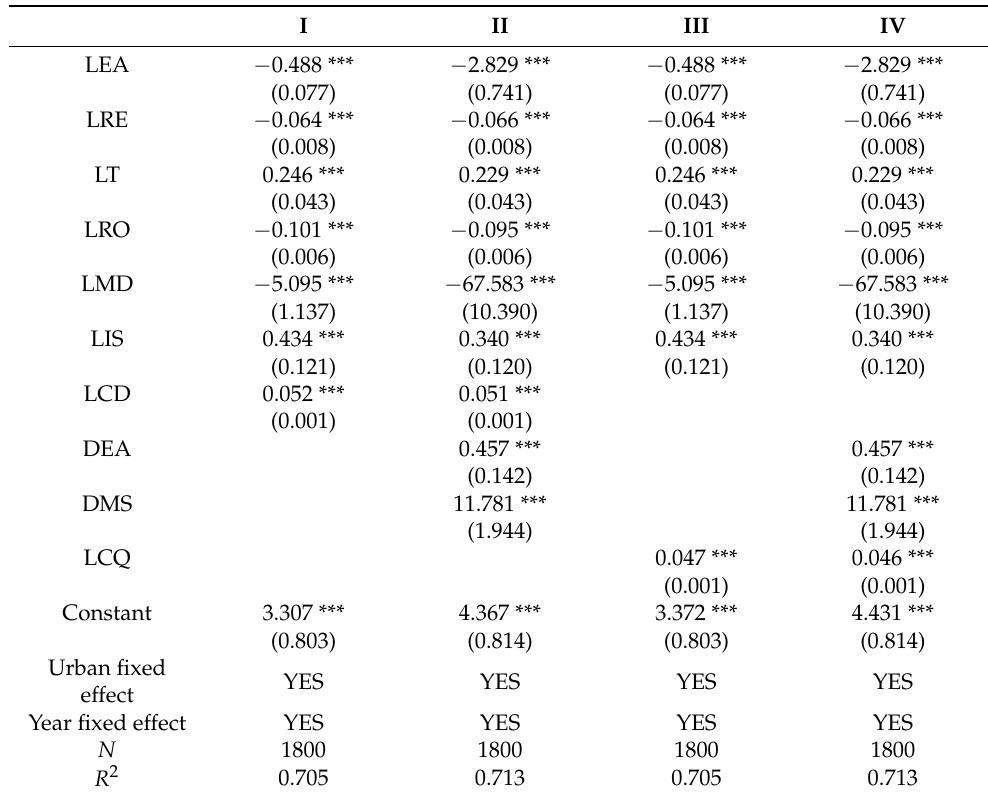
Table 6. Distinguishing the fixed effect of the pushing